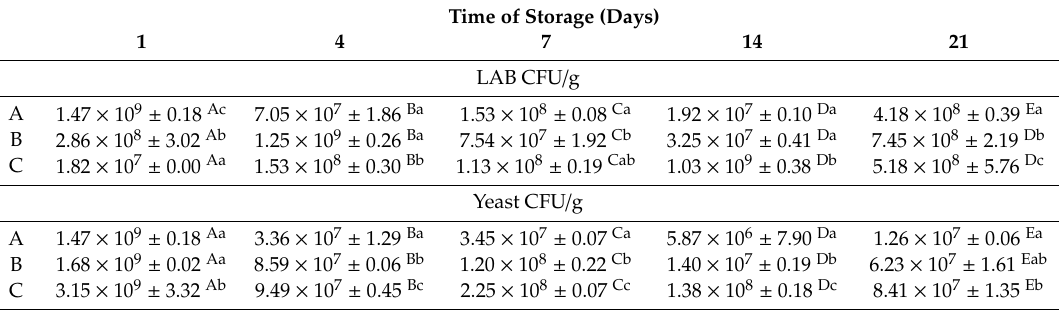
Table 1. Lactic acid bacteria (LAB) and fungi counts during storage time. Time of Storage